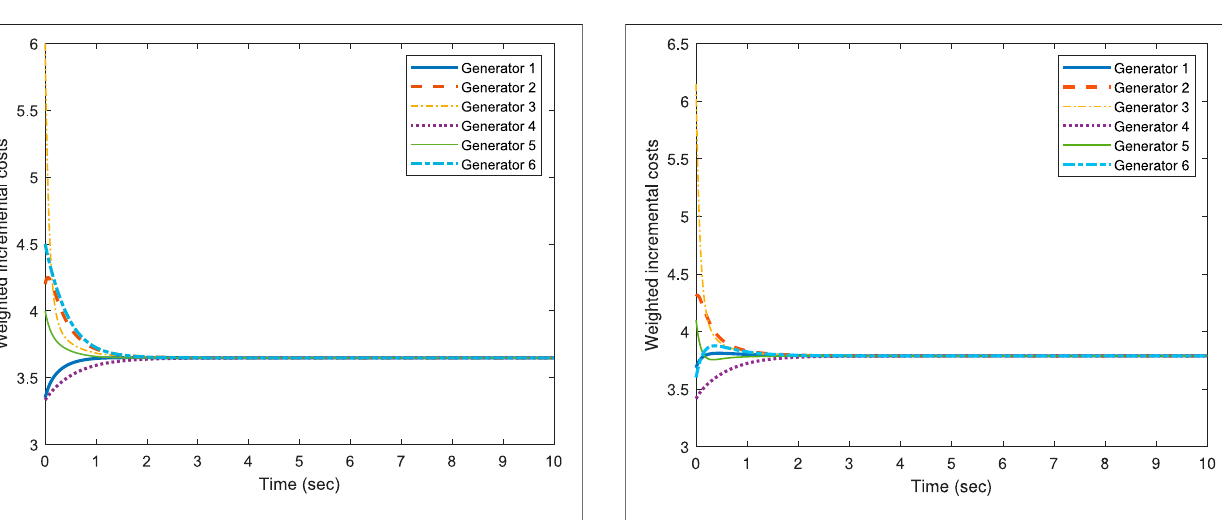
FIGURE 3 | Weighted ICs of individual generators versus time (sec) under the conventional approach (unity weights).